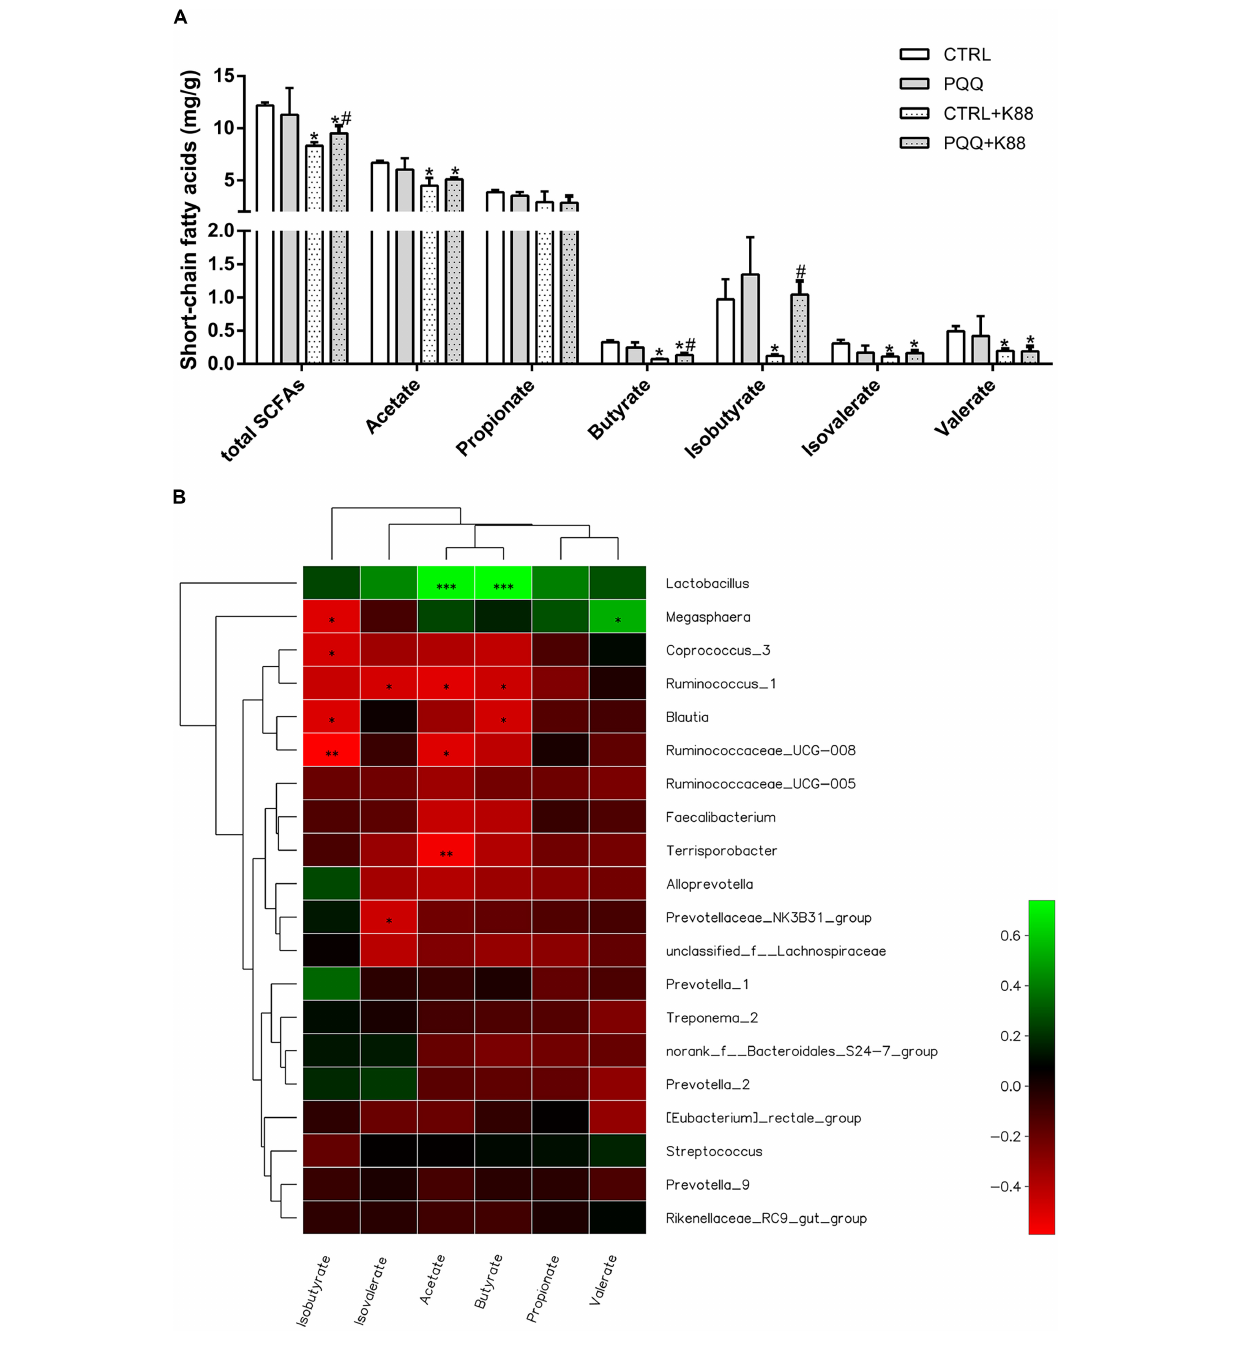
FIGURE 5 | Effects of dietary PQQ supplementation on colonic short-chain fatty acids (SCFAs) in weaned piglets and correlation heatmap of the 20 most abundant genera and SCFAs. (A) Concentration of SCFAs in the chyme of the colon. Data are shown as mean ± SEM. The result was analyzed using the one-way ANOVA with Tukey’s test. ∗ denotes a significant difference ( P < 0.05) compared with the CTRL group. # denotes a significant difference ( P < 0.05) compared with the CTRL + K88 group. (B) X and Y axes present SCFAs and genus, respectively. The correlation coefficients (R) are shown in different colors on the right side of the legend. The value of 0.01 < P ≤ 0.05 is marked with “ ∗ .” The value of 0.001 < P ≤ 0.01 is marked with “ ∗∗ .” The value of P ≤ 0.001 is marked with “ ∗∗∗ ”; n =